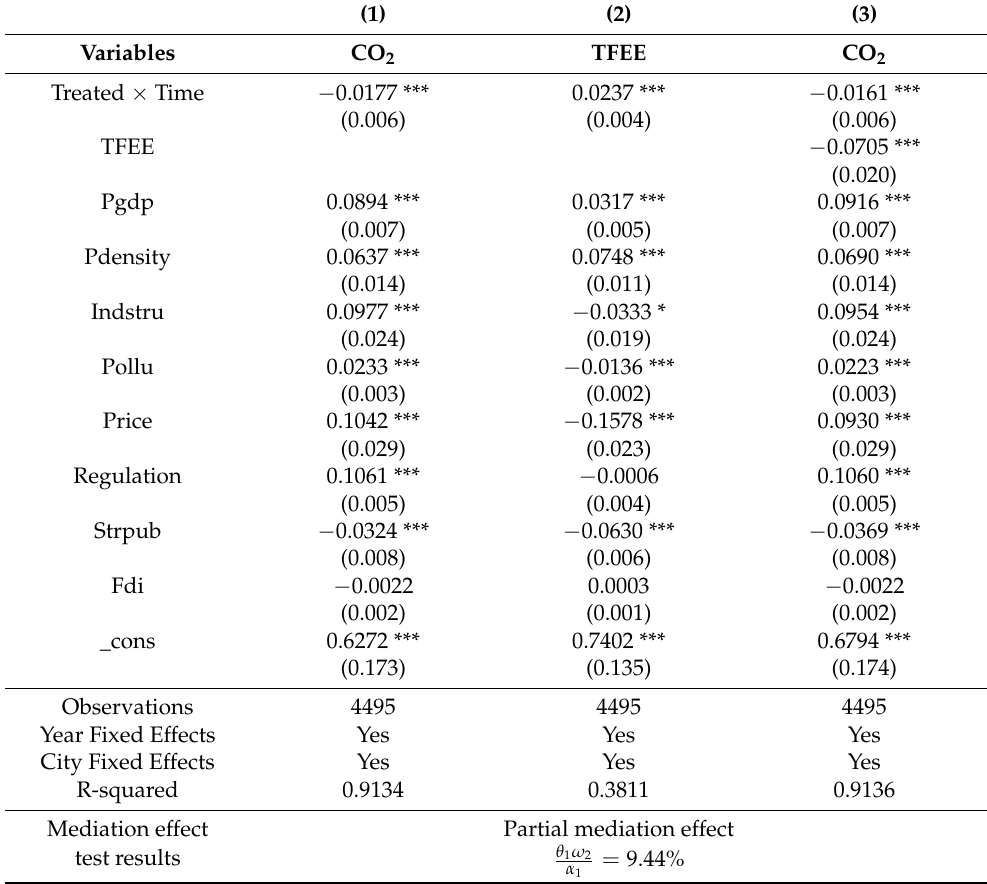
Table 12. Low-carbon city pilot, energy efficiency, and carbon